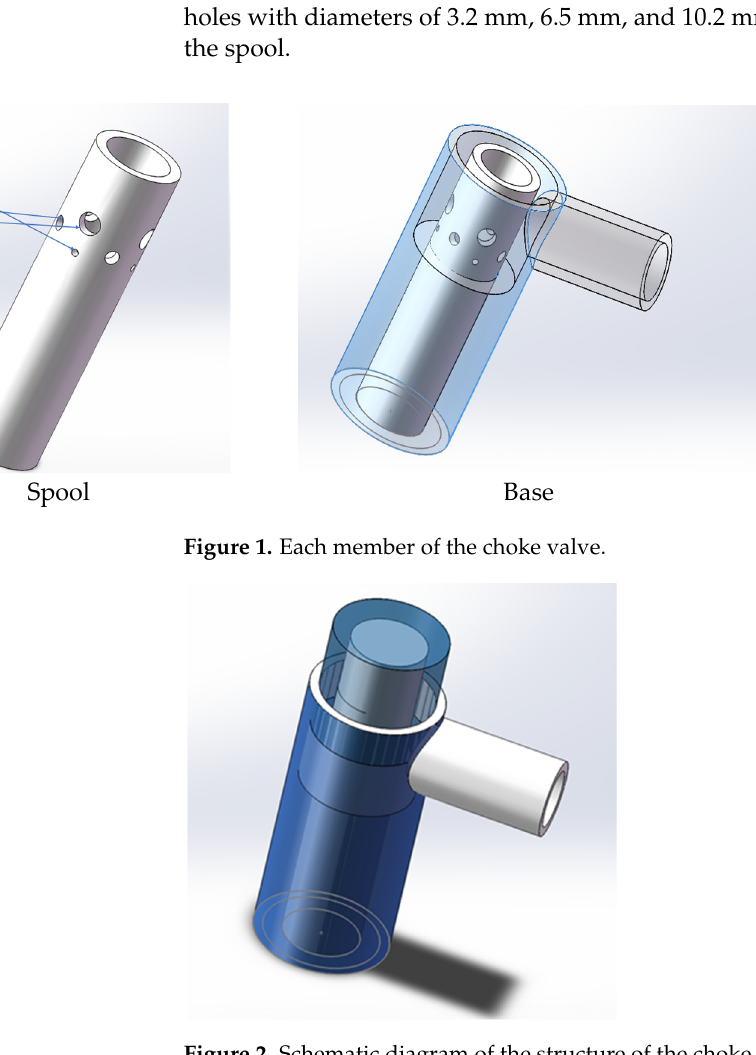
Figure 2. Schematic diagram of the structure of the choke valve.